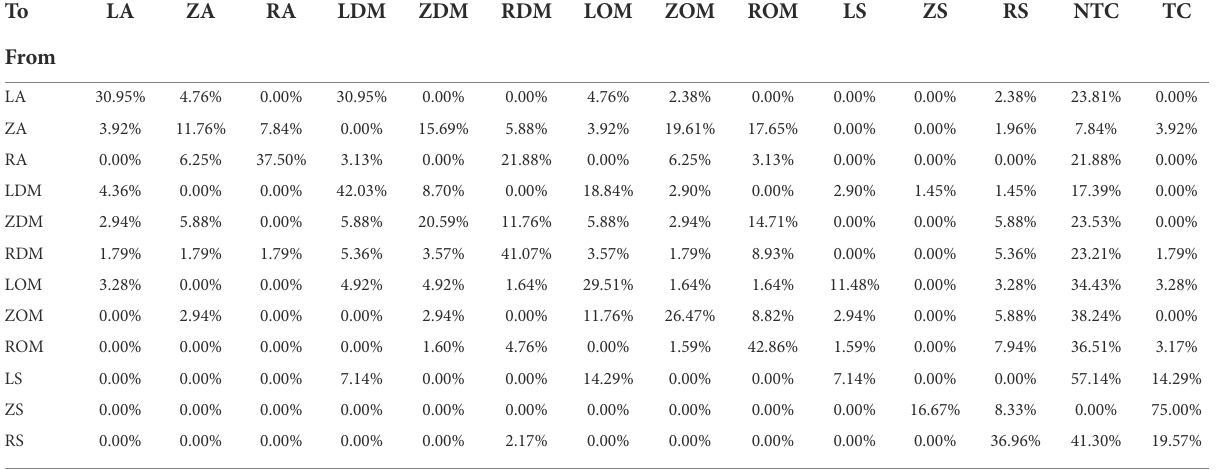
TABLE 2 Example of state transition probability matrix for zones. To